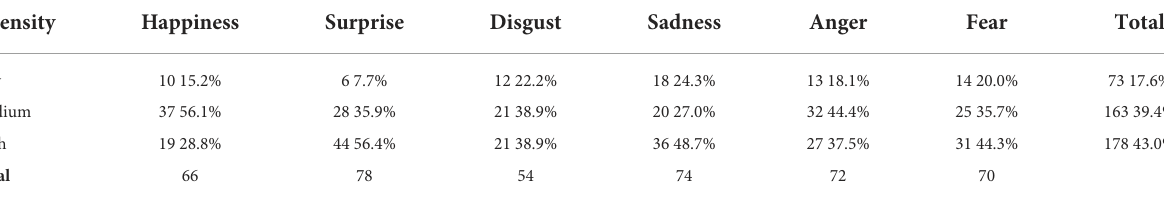
TABLE 4 Intensity perceived for each emotion ( n = number of responses for each level and emotion, % over the total number of answers for each emotion).